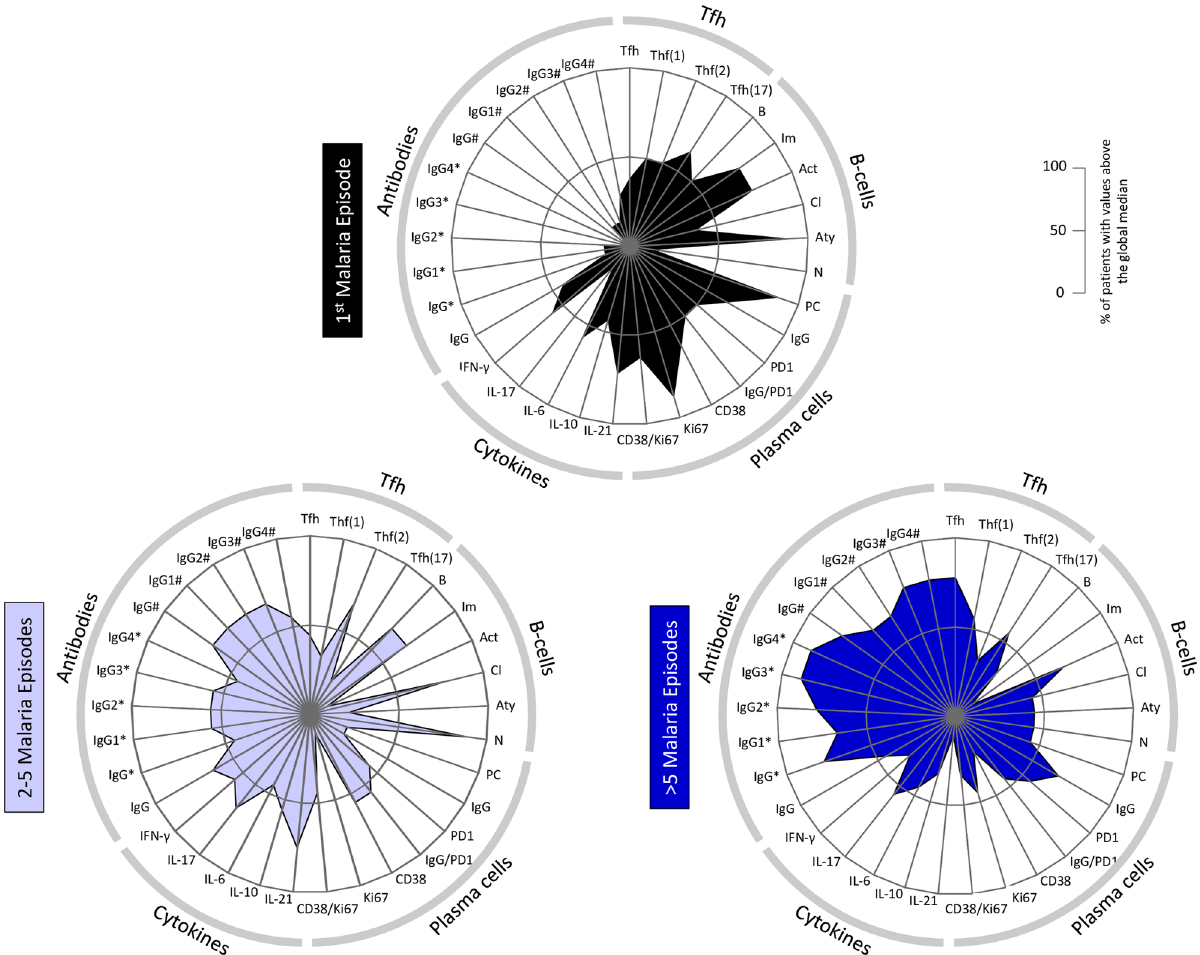
Fig 7. Repeated Plasmodium vivax exposures alter the distribution of the high produces of immunological markers. Radar graphs represent the high producers of Tfh cells, B cells, plasma cells and their subsets, and the levels of cytokines and antibodies(clockwise) assessed in patients undergoingthe first malaria (upper panel)or who had between2–5 lower, left panel)or more than 5 malaria episodes (lower, right panel). The inner circle represents the 50 th percentilefor each parameter, which was taken as threshold to define relevant frequencyof patients with higherlevels of a given biomarker. * and # represent,respectively,immunoglobulinsspecific for AMA-1 and MSP- 1 19